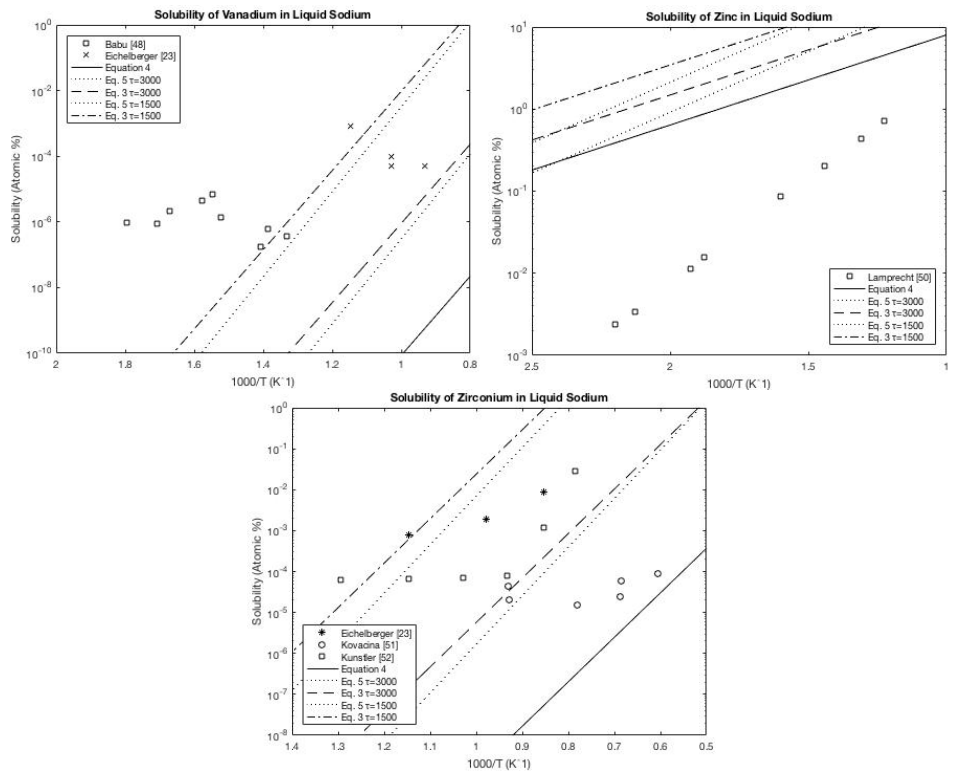
Figure A2. Solubility of additional transition metals in liquid sodium compared to the model.